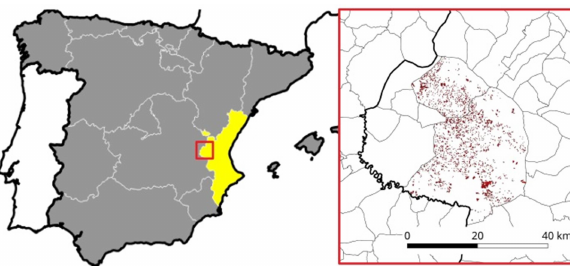
Figure 1. Location of the study area in the Valencian region (Spain): Overview (left) and detail with the distribution of the crop parcels depicted in red (right).